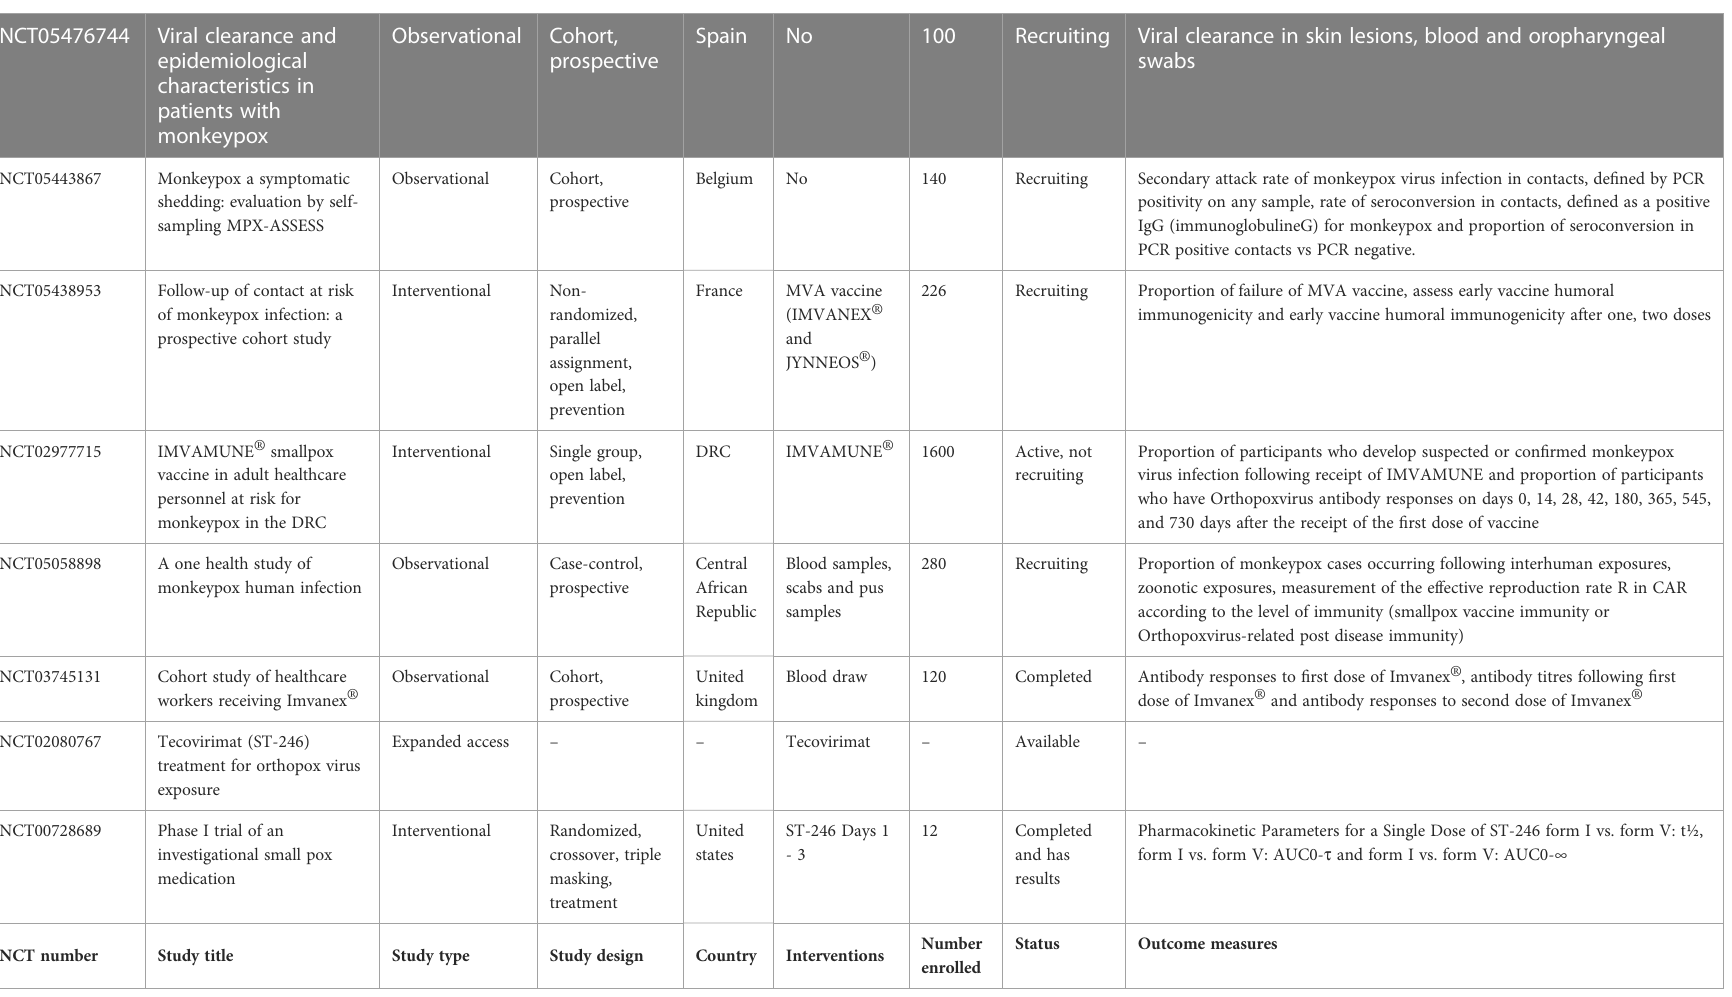
TABLE 3 Representing data of case studies on monkeypox registered with